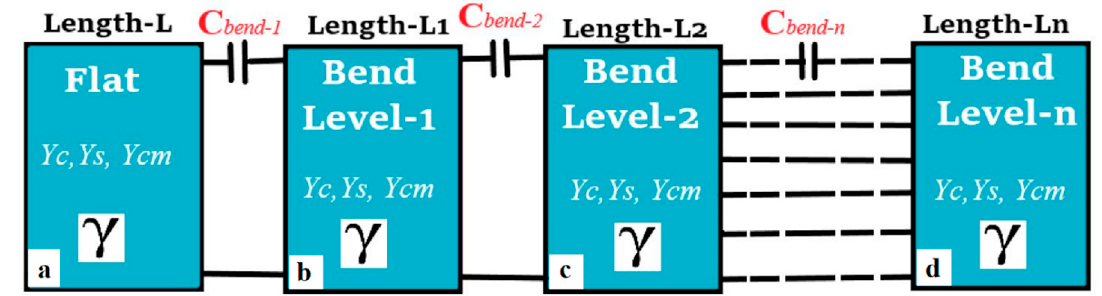
Figure 2. Antenna Equivalent Model for bent conditions, with circuit parameters Yc, Ys, Ycm ( a ) flat antenna, ( b ) Level 1 presents a minor radial bending, ( c ) Level 2 is higher, and ( d ) Level n is the highest level of curvature.